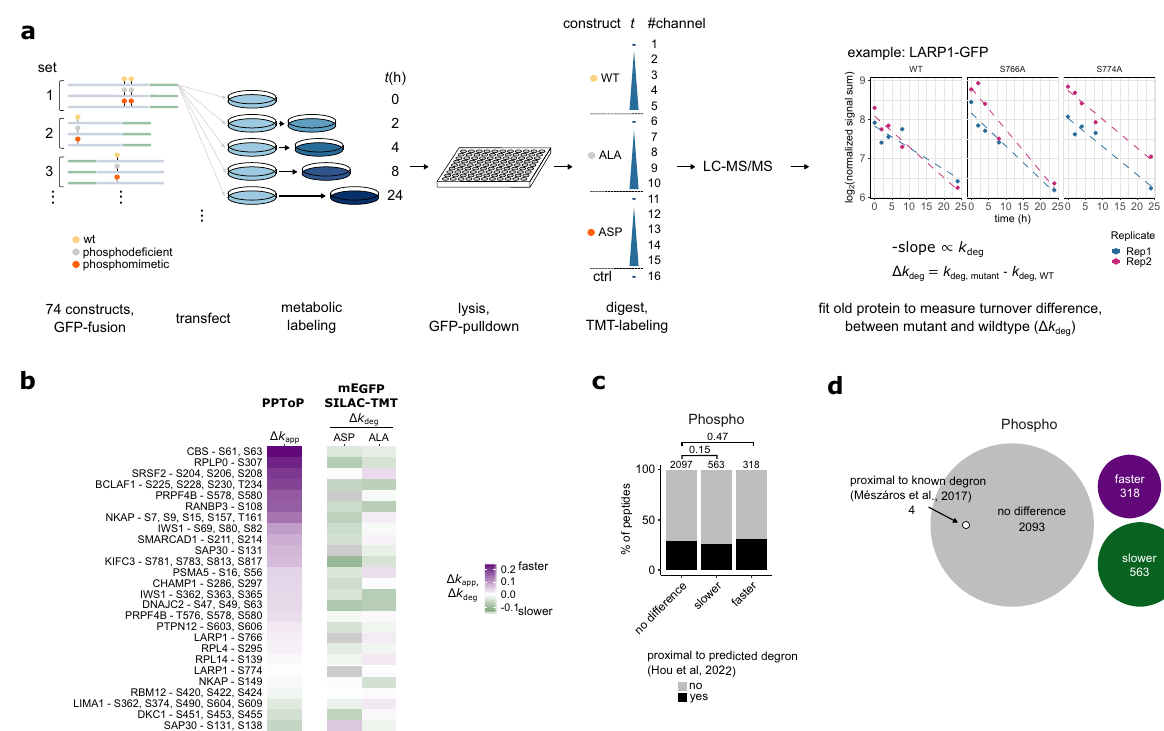
Fig. 5| Differentialclearanceofphosphopeptidesis notpredictiveofeffectsof phosphorylation on a protein ’ s proteolytic stability. a Experimental setup for interrogating effects of phosphosite mutations on protein proteolytic stability. Turnoverofexogenouslyexpressedproteinswasquanti fi edfromTMTsignalsums of the oldproteinfrompull-down experiments, and compared to the turnoverof a corresponding, similarly-tagged and expressed wild-type (WT) construct. b Comparison of differences in clearance rates from PPToP ( Δ k app ) and wild-type- to-mutantdifferences( Δ k deg )fromtheexogenousexpressionexperimentshowno